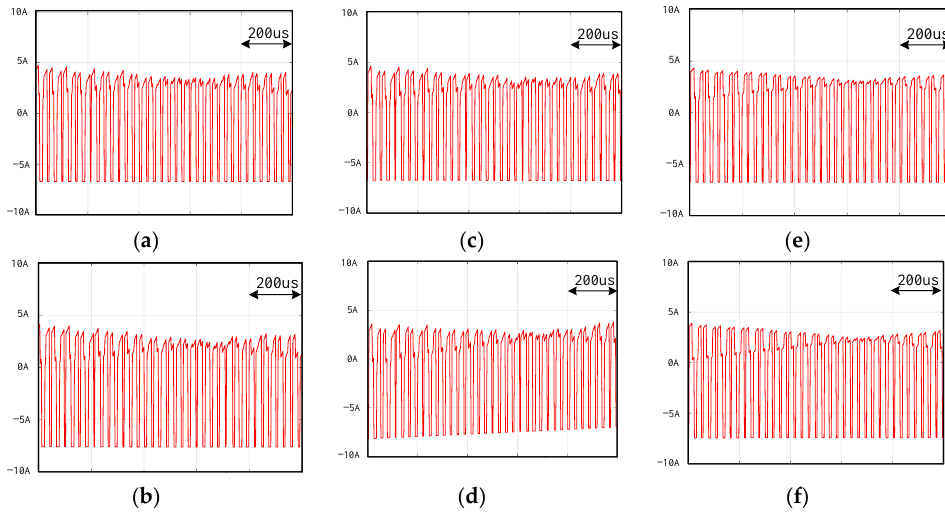
Figure 8. The simulated voltage v CT and current i CT of the DC-link capacitor under test for ( a , c , e ) balanced and ( b , d , f ) unbalanced load condition in the ( a , b ) full-scale voltage rating VSI, ( c , d ) con- ventional down-scale voltage rating evaluation system, and ( e , f ) proposed down-scale voltage rat- ing evaluation system.